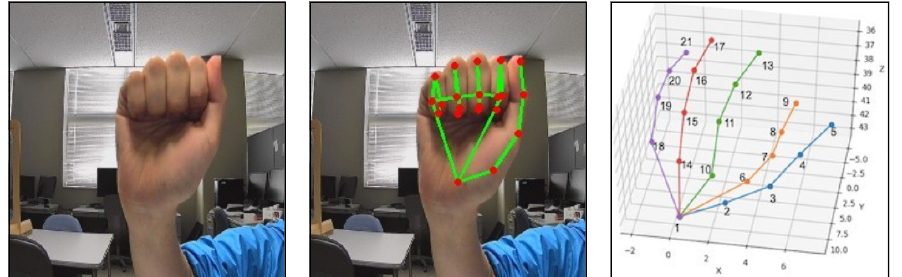
Figure 3. Using media-pipe API to obtain 21 joint points. The image in the left is an input image, the image in the middle is presenting the estimated joints and the image in the right is showing the joint